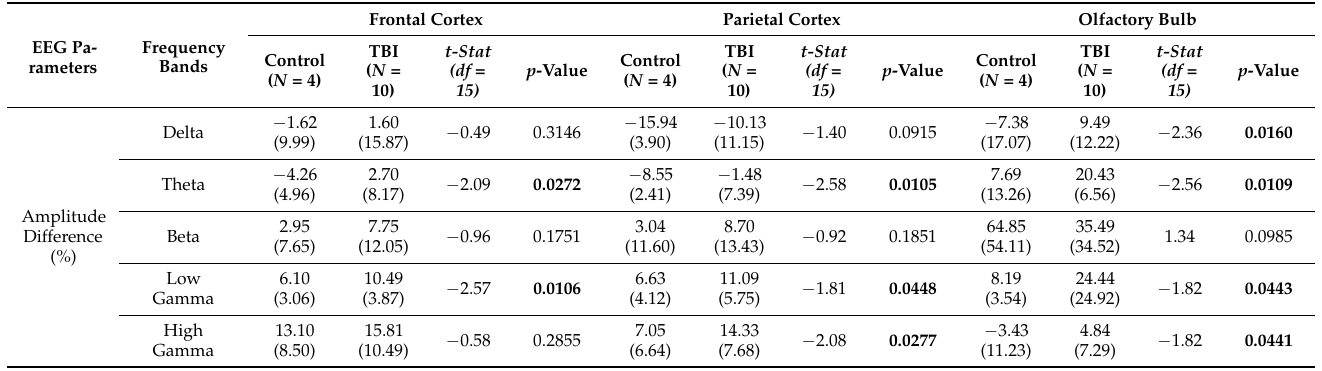
where P standard and P deviant are powers during standard and deviant odor stimulations, respectively.